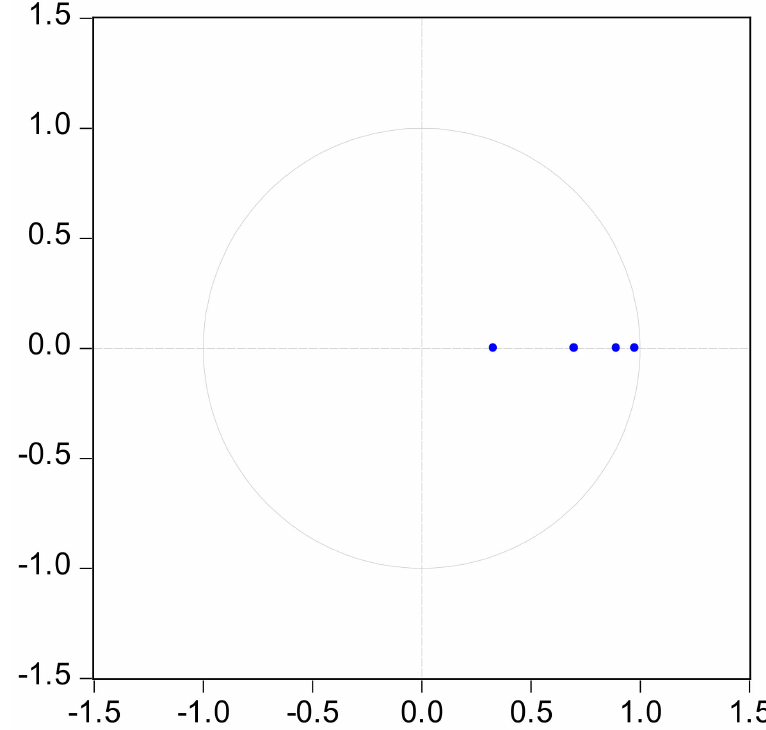
Figure 2. Inverse roots of AR characteristic polynomia.